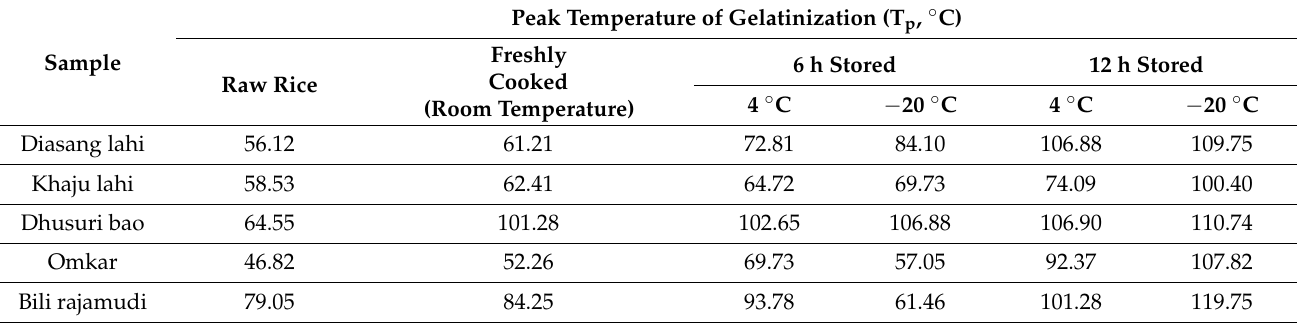
Table 1. Peak temperature of gelatinization (T p , ◦ C) of native starch and retrograded rice samples.